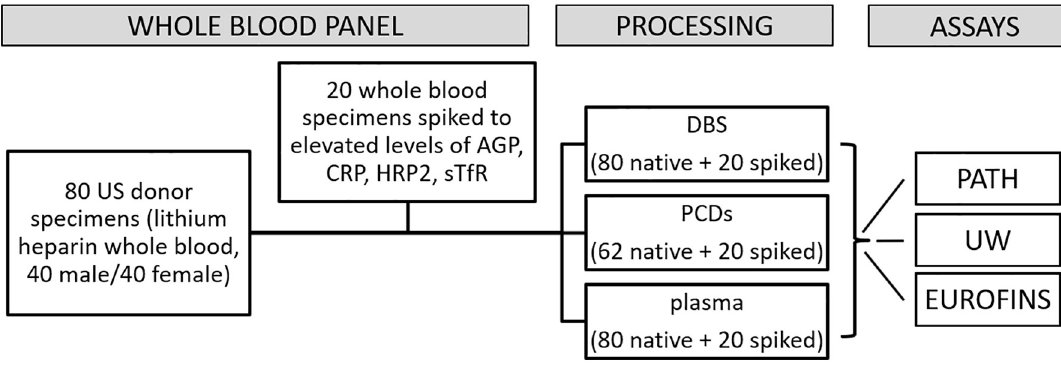
Fig 1. Sample panels and experiment